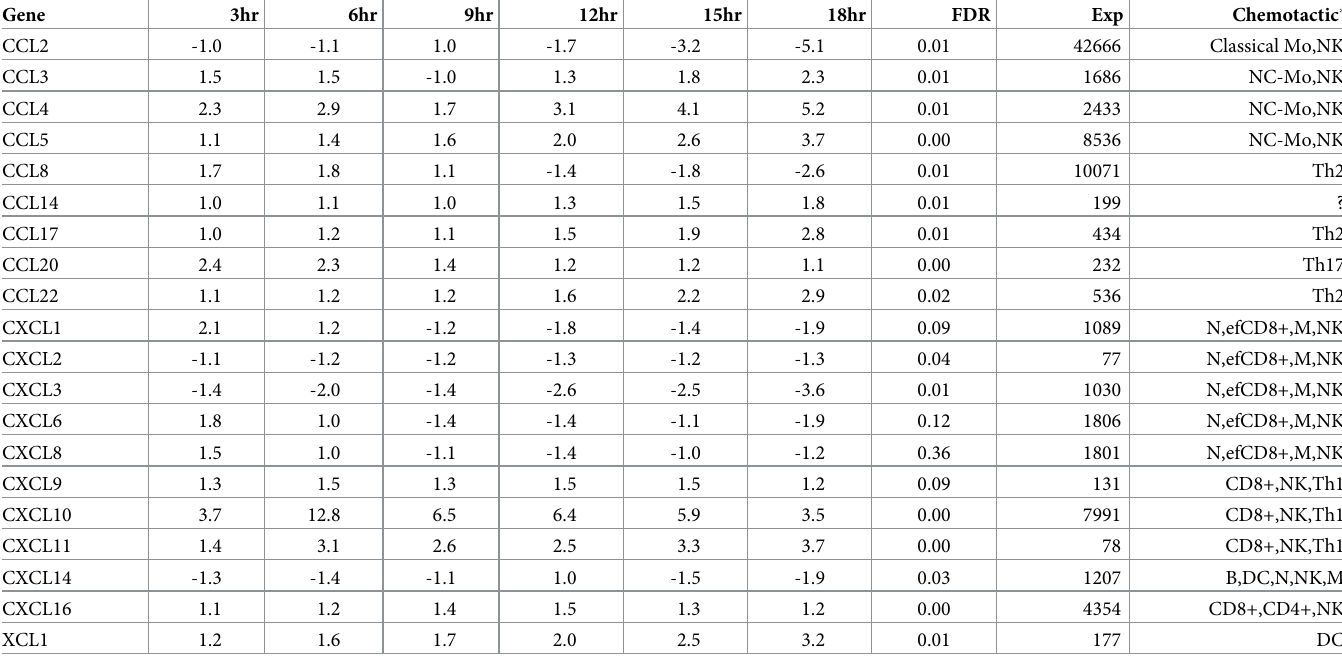
Table 5. Differential expression (fold = infected/non-infected) with a FDR less than 0.05 at one or more time points and the averaged expression level (Exp) of che- mokine genes between infected and non-infected macrophages at 3, 6, 9, 12, 15 and 18 hours post infection and their chemotactic activities.